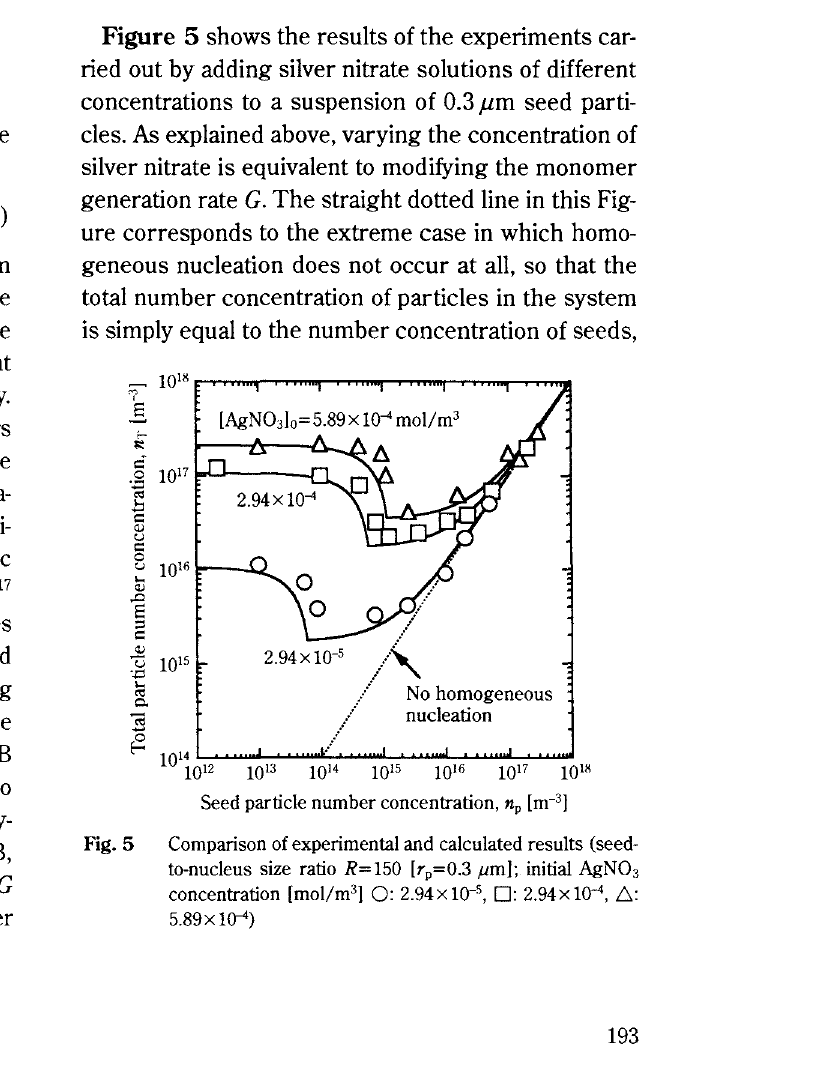
Comparison of experimental and calculated results (seed to-nucleus size ratio R=150 [rp=0.3 ,urn]; initial AgN0 3 concentration [mol/m 3] 0: 2.94x 10-s, 0: 2.94x 10-4,